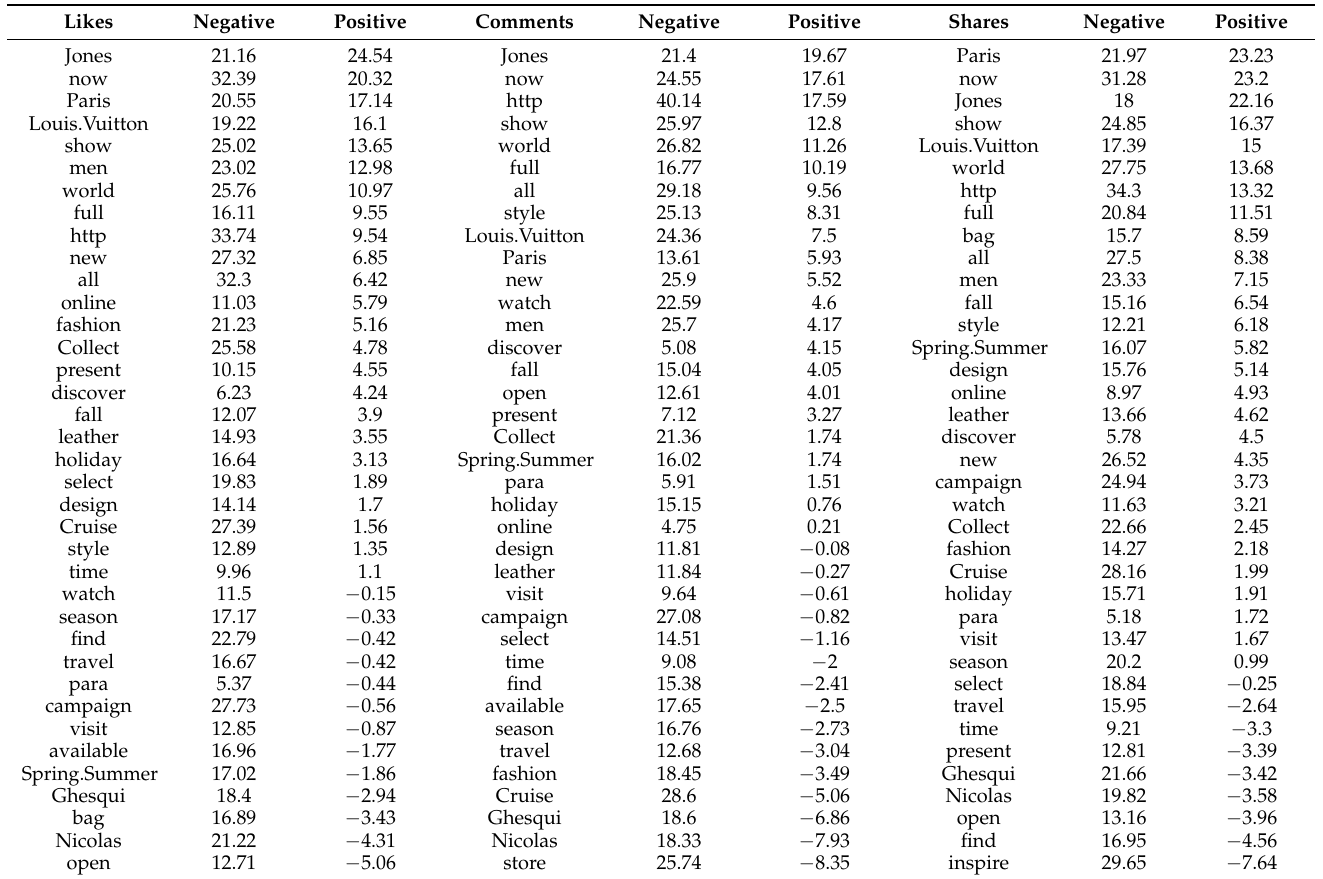
Table A1. Negative and positive cues for Louis